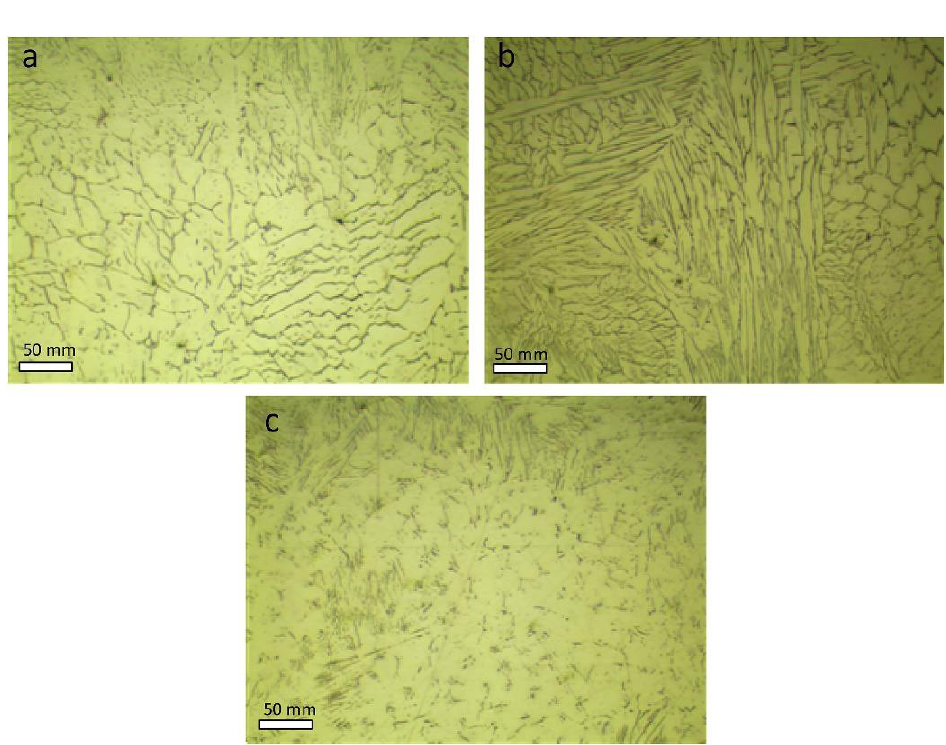
Figure 1. Optical images of the etched austenite + vermicular ferrite microstructure images of AM samples of the AISI 304 steel grown at heat input values ( a ) 0.22, ( b ) 0.25, and ( c ) 0.27 kJ/mm as viewed along the build-up direction. Reprinted with permission from [8], Copyright 2019 Elsevier.